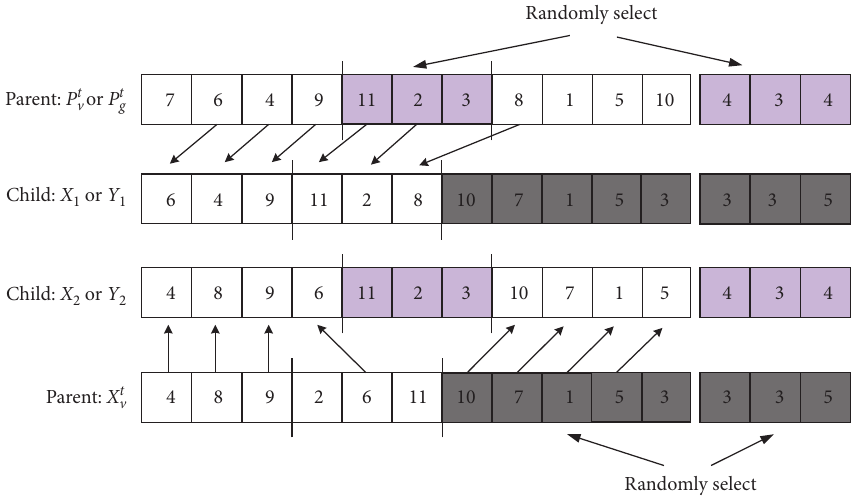
Figure 8: Crossover operation schematic diagram.